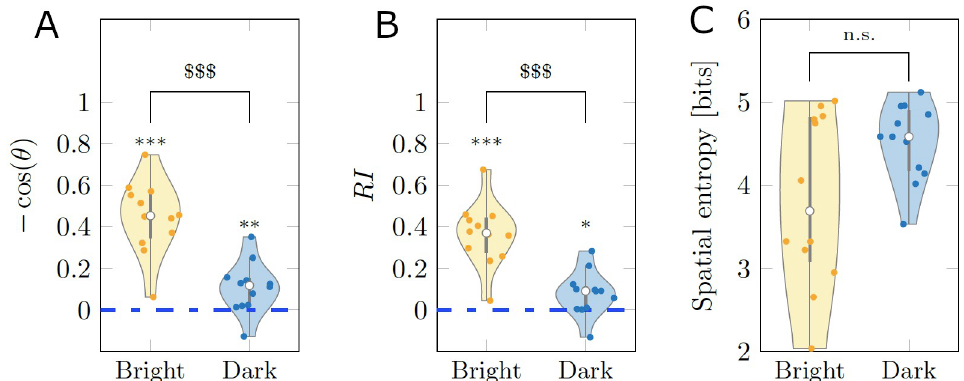
Fig 1. Average scoring of three behavioral metrics for real experiments. (A-B) Rheotactic metrics taking values between − 1 and 1 corresponding to biased headings downstream and upstream, respectively. (C) Spatial entropy, measuring the exploratory behavior across the test section. The average was taken over the entire time series of 9, 000 points for each experimental subject. The gray bar in each violin plot details median (white dot), first and third quartiles, and lower and upper adjacent values. The colored area of a violin plot corresponds to the probability density of the data. Symbols � , �� and ��� indicate significant differences from zero with p < 0.050, p < 0.010, and p < 0.001, respectively. Symbol $$$ indicates significant difference between conditions with p <